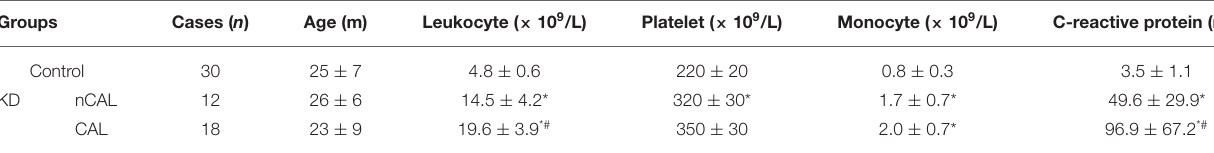
TABLE 1 | Blood routine test results of selected patients and normal controls. Groups